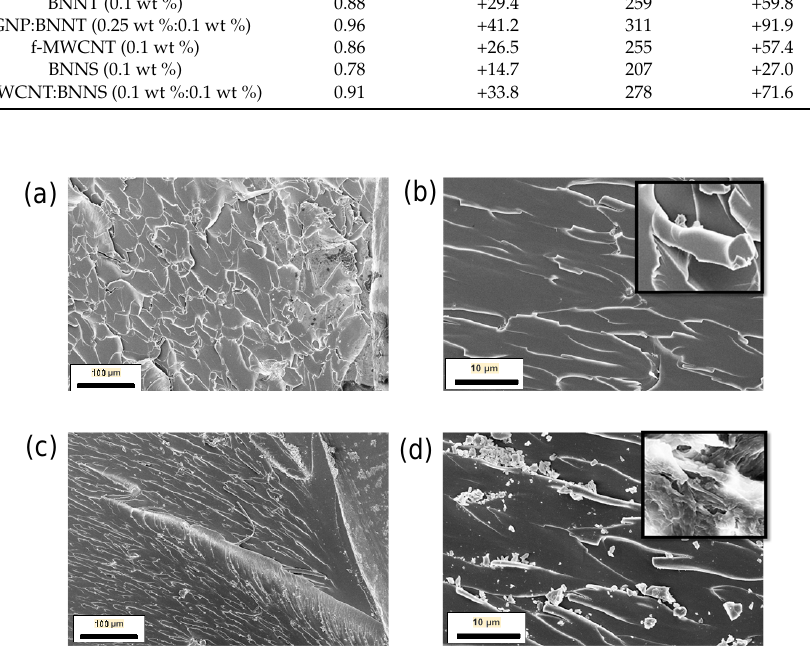
Figure 8. Fracture surface SEM images of the hybrid nanocomposites at magnification ( a ) 500× and ( b ) 5000× for 0.25: 0.1 wt % (f-GNP:BNNT)/Epoxy; at magnification ( c ) 500× and ( d ) 5000× for 0.1:0.1 wt % (f-MWCNT: BNNS)/Epoxy.